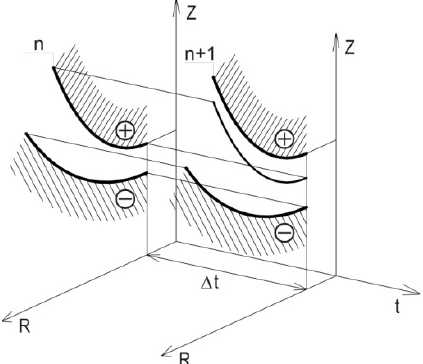
Figure 2. Effect of ECM time on shape evolution (WP). To solve energy Equation (11), the finite difference method was applied, determining the temperature distribution across and along the gap. Considering the accuracy